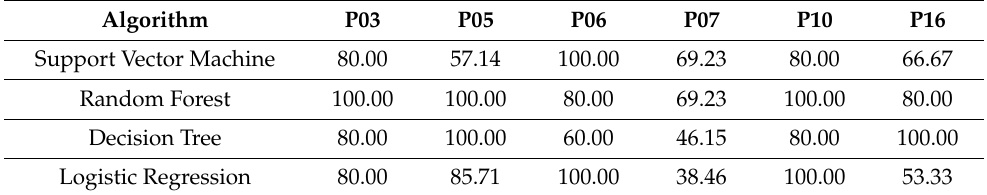
Table 7. Accuracy (%) of every ML model obtained with all the variables for some of the patients.